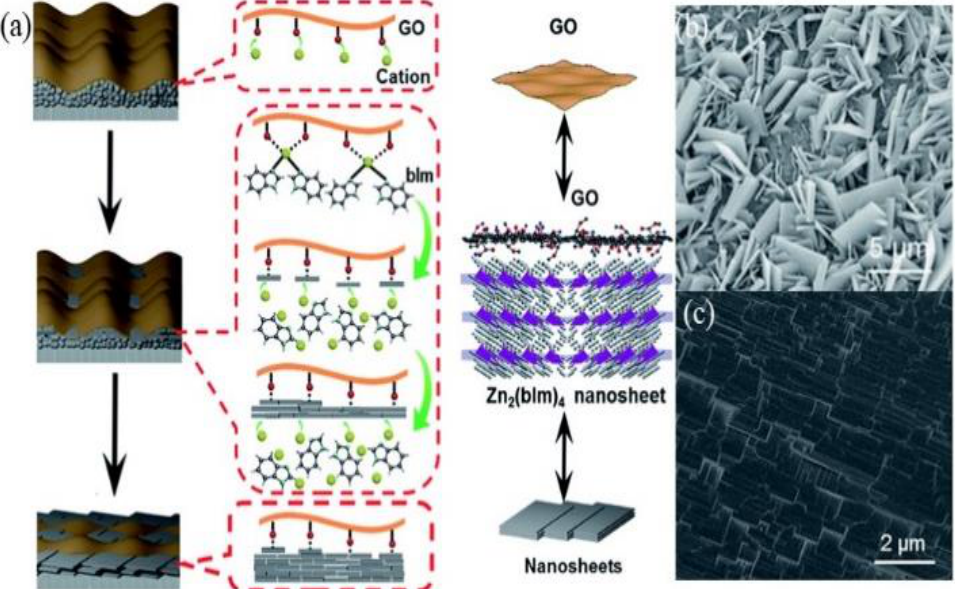
Figure 6. ( a ) Formation mechanism of a highly oriented nanosheet membrane with the aid of GO on porous alumina substrate, SEM images, ( b ) self-conversion of ZnO NPs without GO layer, and ( c ) self-conversion of ZnO NP–GO layer. Reproduced with permission from [21]. Copyright 2018 and 2010, Royal Society of